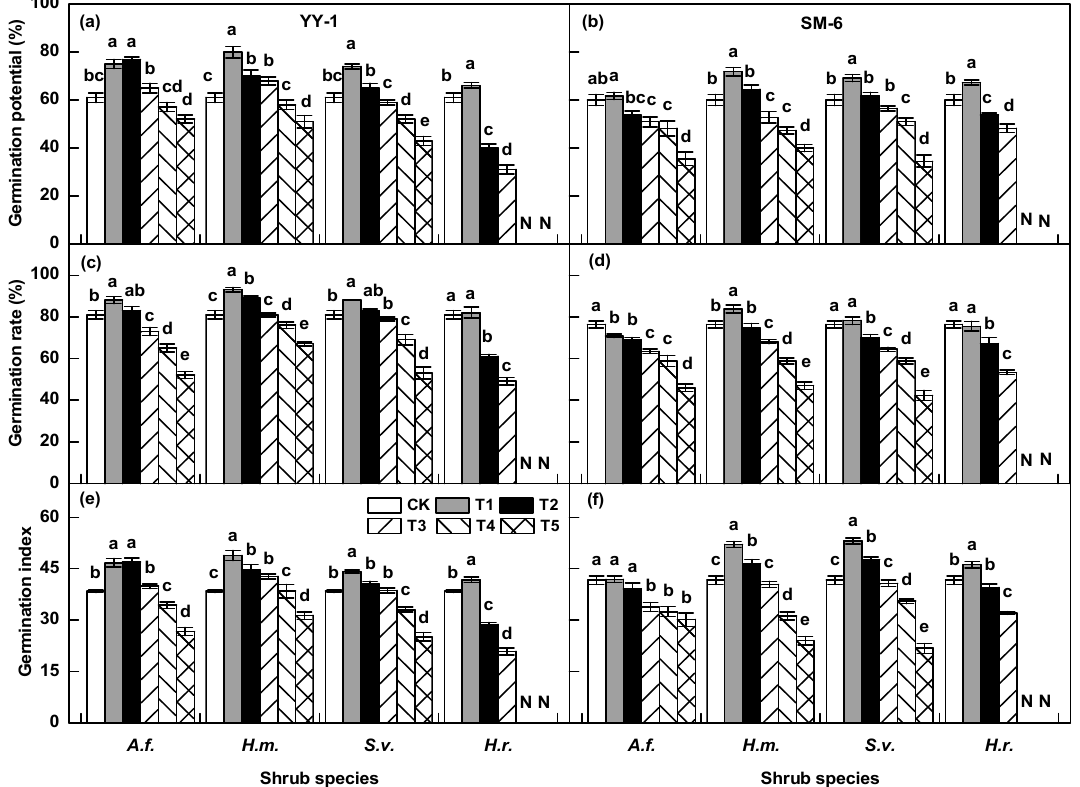
Figure 1. Effect of different concentrations of four shrub species’ aqueous leaf extracts on seed germination of Amygdalus pedunculata . ( a – f ). Data (Mean ± Standard Error, n = 42) of the germination potential ( a , b ), germination rate ( c , d ), and germination index ( e , f ) of the target A. pedunculata species YY-1 from Yuyang County (YY) and SM-6 from Shenmu County (SM) exposed to six concentrations (0 (CK), 0.025 (T1), 0.05 (T2), 0.1 (T3), 0.15 (T4), and 0.2 g · mL − 1 (T5)) of aqueous leaf extracts from the donor species— Amorpha fruticosa ( A.f. ), Hedysarum mongolicum ( H.m. ), Sabina vulgaris ( S.v. ), and Hippophae rhamnoides ( H.r. )—for 10 days in petri dishes (four replicates of 25 seeds each). N means no value (the seeds did not germinate and died). Different little letters indicate significant difference ( p < 0.05). Vertical bars represent standard errors ( n = 4).